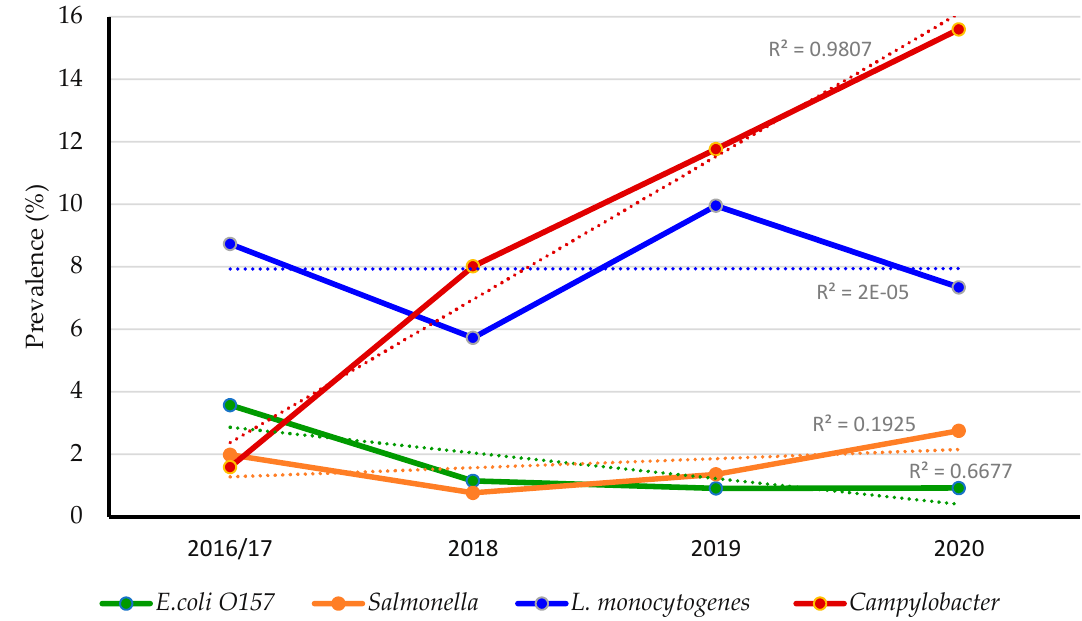
Figure 1. Prevalence of foodborne pathogens in dairy cattle and poultry manure amended farms between 2016 and 2020.